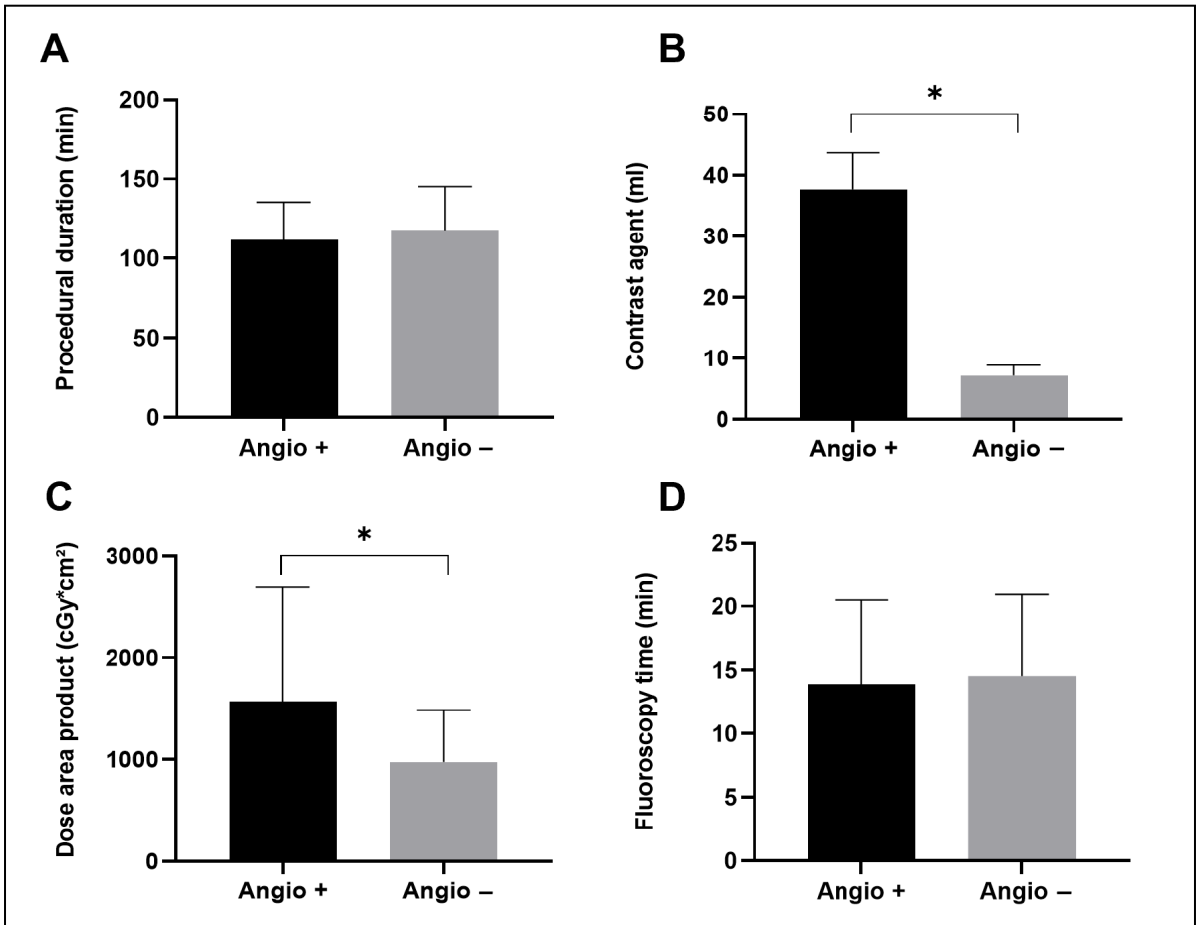
Figure 2. Comparison of selected procedural parameters between patients who had received PV angiography (Angio +) and those without PV angiography (Angio − ) (mean with standard deviation). ( A ) shows the procedural duration, ( B ) shows the volume of contrast agent applicated during the whole procedure, ( C ) shows the dose area product for fluoroscopy and ( D ) shows the fluoroscopy time. * indicates statistical significance.